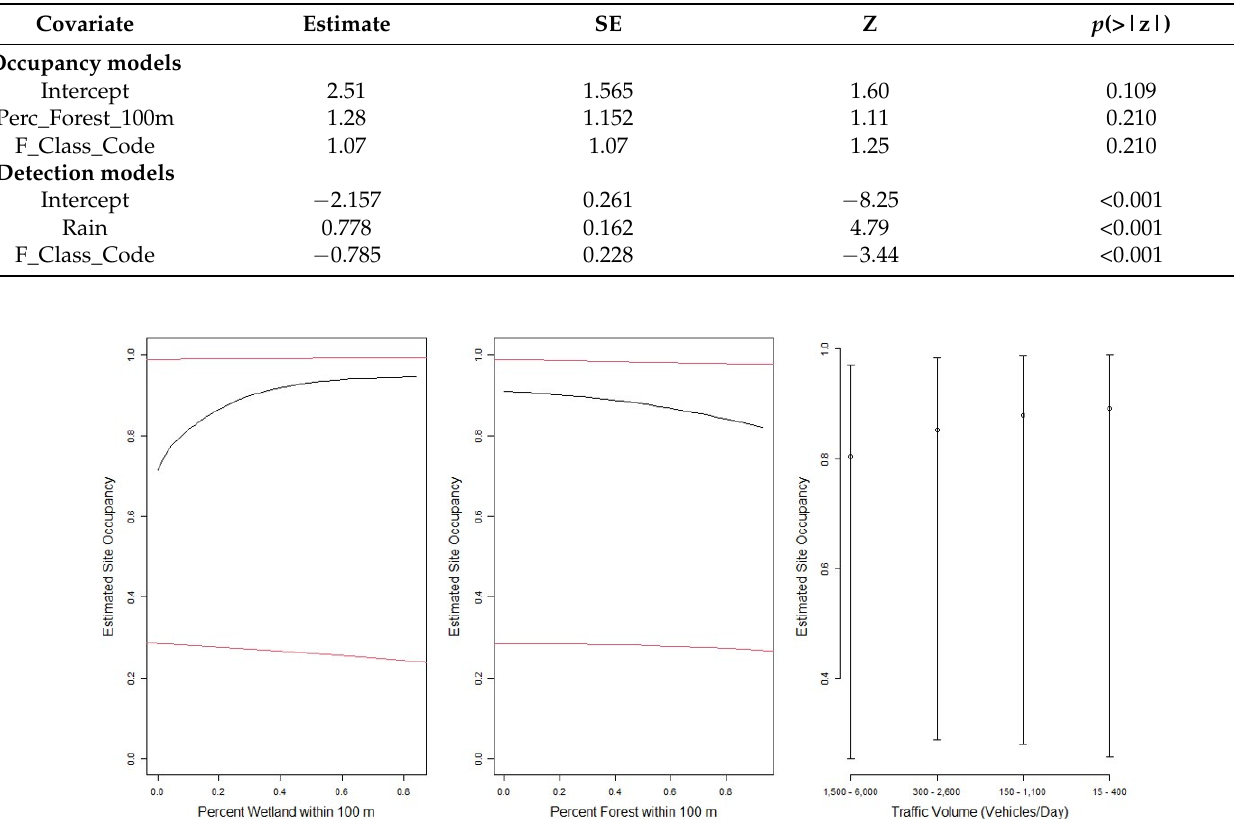
Figure 1. Marginal effect of covariates on estimated site occupancy from the model-averaged results. Black lines represent model estimates for occupancy, and red lines represent upper and lower con- fidence intervals. Plots hold other covariates at their mean value.